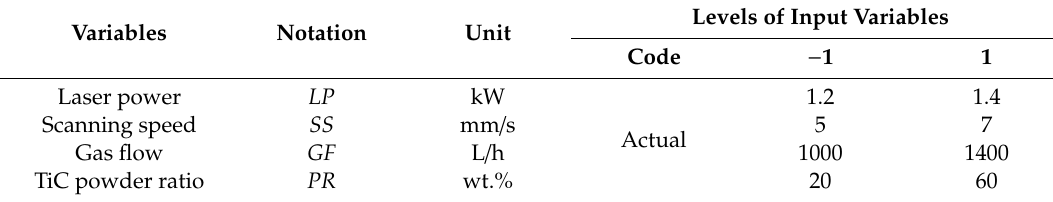
Table 3. Studied process variables and levels.